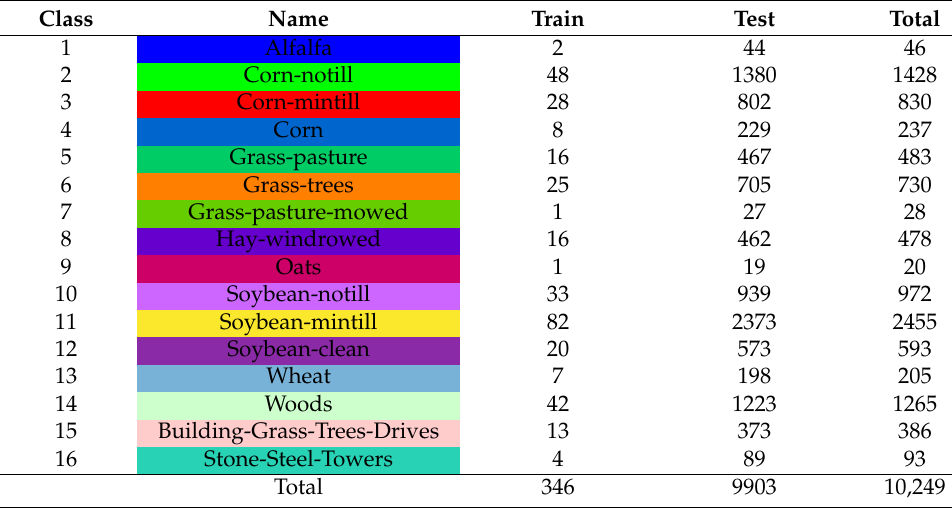
Table 2. Train-test distribution of samples for the Pavia University dataset.